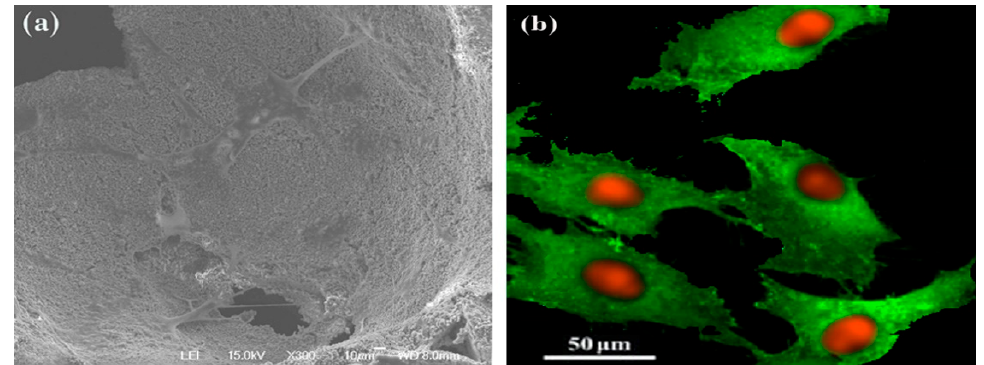
Figure 9. ( a ) Cellular morphology by scanning electron microscopy and, ( b ) confocal laser scanning microscopic image of osteoblasts spread on 10% Mn-BCP-MAN scaffold.